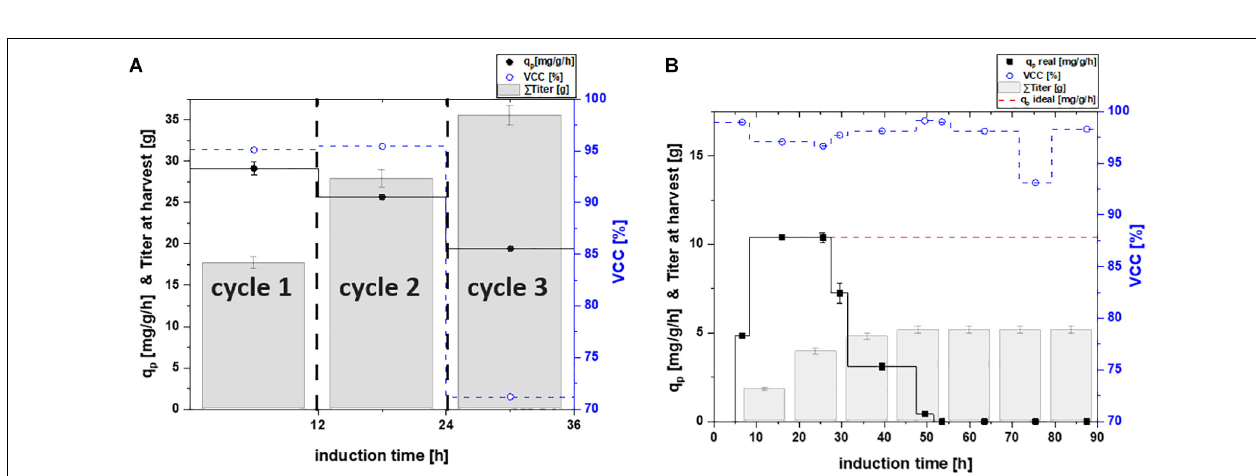
FIGURE 2 | Specific productivity q p (mg/g/h), viable cell concentration (=VCC) [%] and the harvested product titer for (A) a repetitive fed-batch cultivation and (B) a chemostat process; a theoretical ideal chemostat was simulated at q p , max .; VCC was evaluated by flow cytometry analysis with an average standard deviation of 2%.